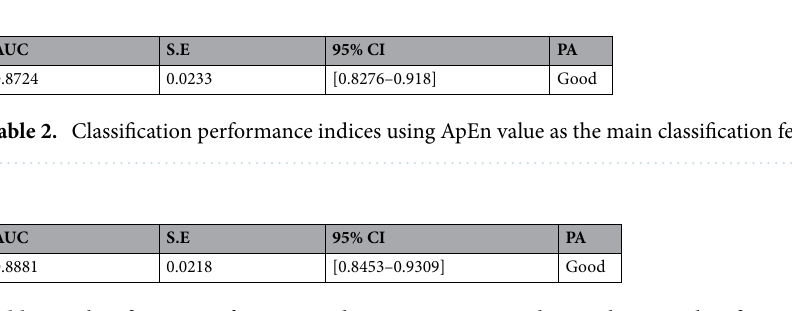
Table 3. Classification performance indices using MApEn values as the main classification